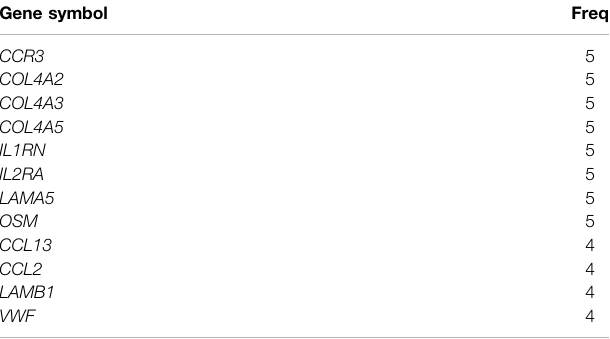
TABLE 3 | Frequency of genes that were reproducible among fi ve algorithms. Gene symbol